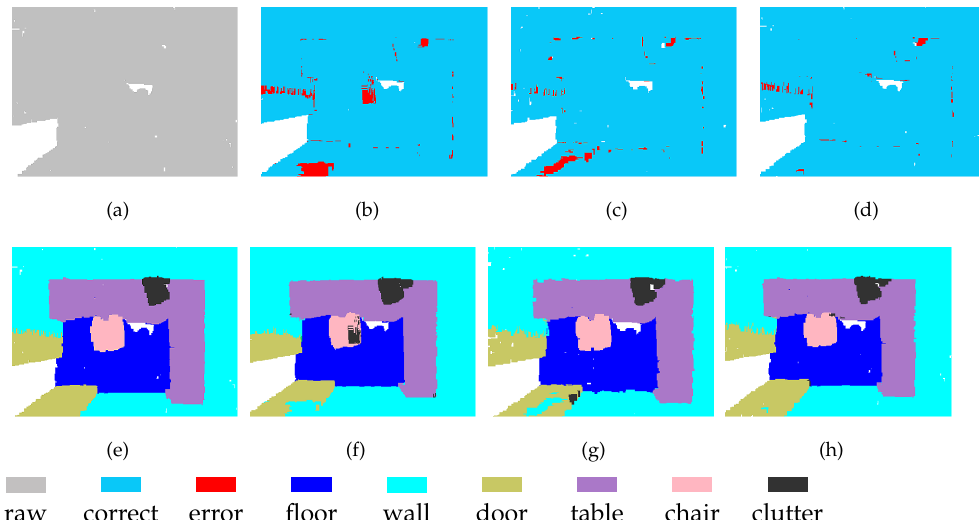
Figure 8. Segmentation results on S3DIS-5 dataset: ( a ) input, ( e ) ground truth, ( b , f ) Level-1, ( c , g ) Level-2, and ( d , h ) MSSCN.